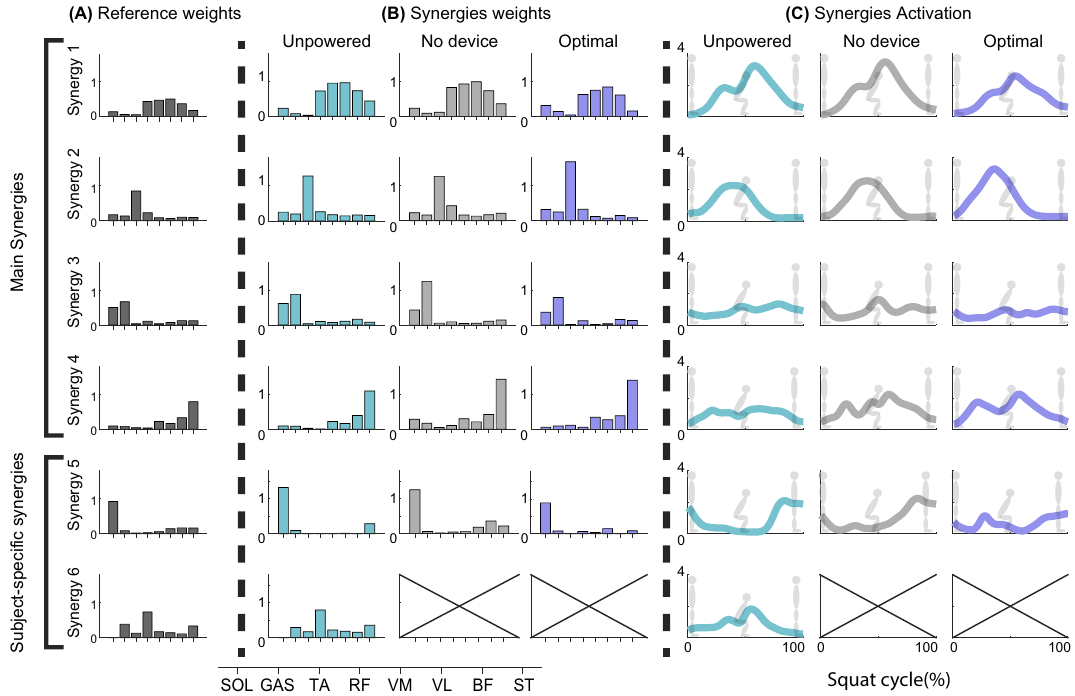
Figure 3. Muscle synergies from the assisted leg. ( A ) Reference weights from the K-means algorithm applied to 10 subjects’ data in all conditions. ( B ) Synergy weights assignment without duplication by condition. ( C ) Synergy activations, mean trajectories of all subjects, of corresponding synergy weights in ( B ).